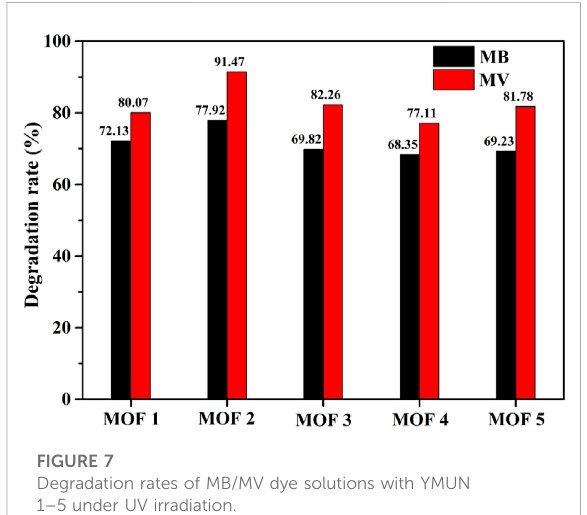
FIGURE 7 Degradation rates of MB/MV dye solutions with YMUN 1 – 5 under UV